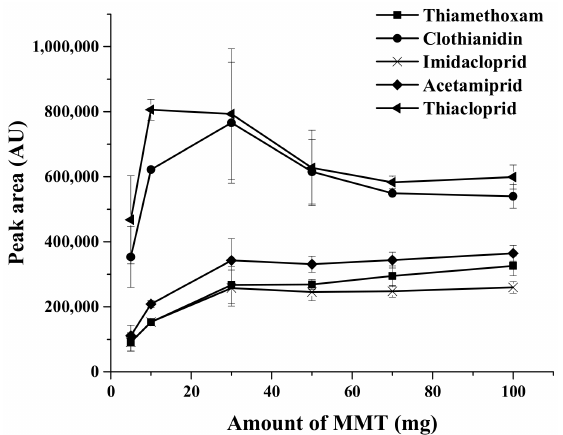
Figure 1. Effect of amount of montmorillonite (MMT) sorbent on the extraction efficiency, using a sample volume of 10 mL, 0.1 g of Na 2 SO 4 , and 200 µ L of acetonitrile as desorption solvent. AU: Absorbance